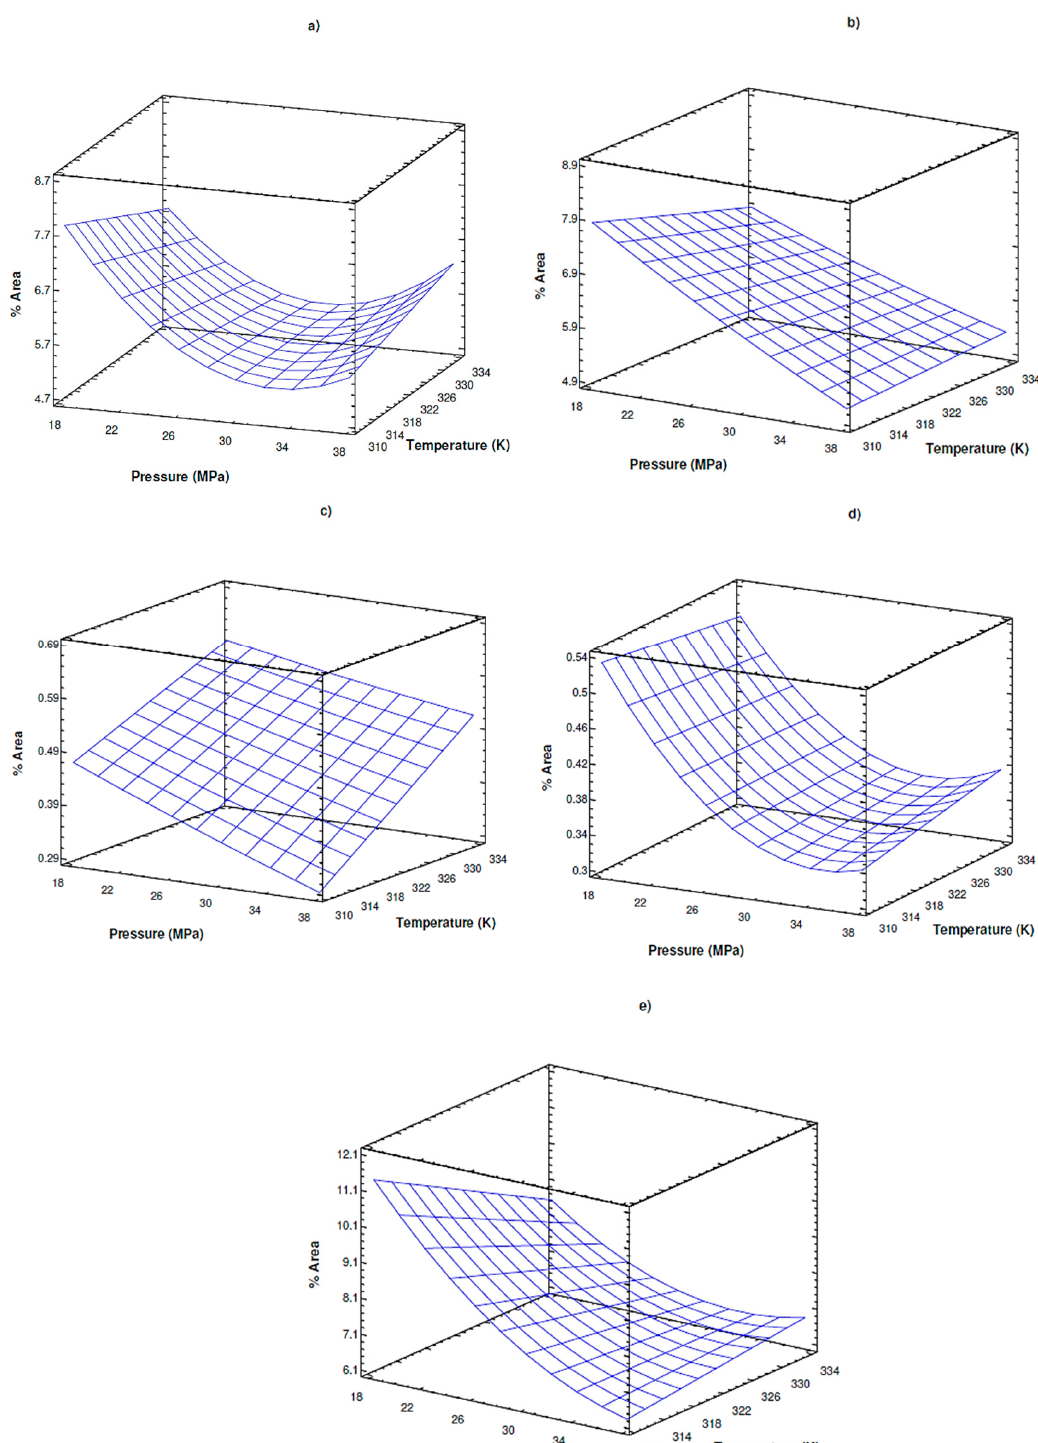
Figure 4. Effect of pressure and temperature on characteristic tuberose flower compounds: ( a ) benzyl benzoate, ( b ) heptacosene, ( c) methyl anthranilate, ( d ) methyl isoeugenol, ( e ) pentacosane.